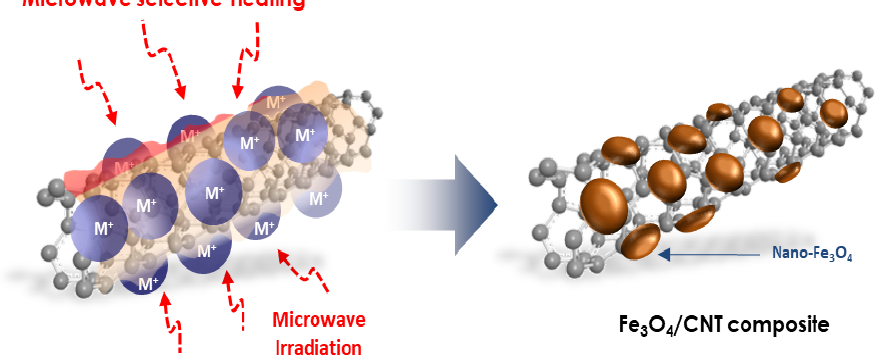
Figure 1. Schematic illustration of formation of the nano-Fe 3 O 4 /CNT composite using microwave solvothermal process.